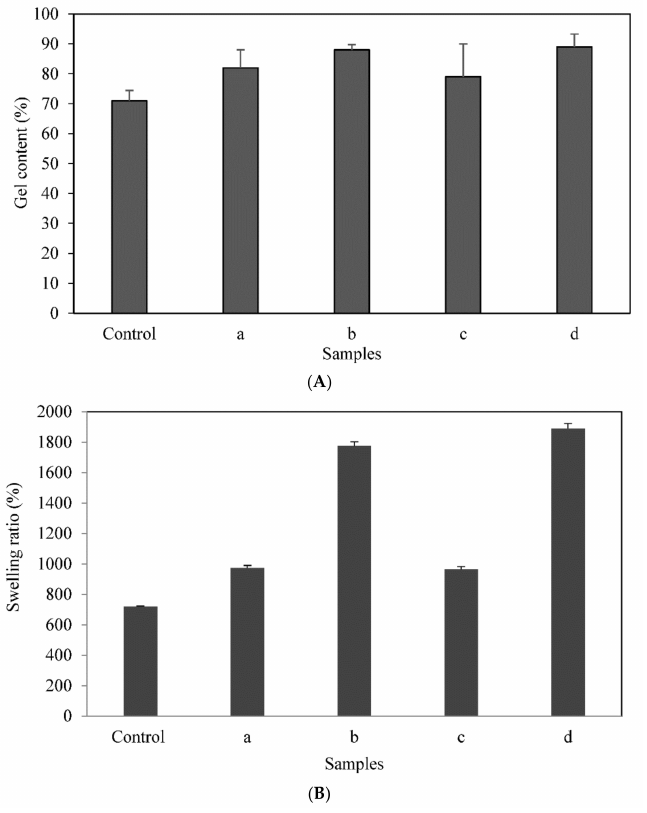
Figure 7. Effect of gel content ( A ) and swelling ratio ( B ); control sponge, ( a ) Alg-CMC ratio (5:5); ( b ) Alg-CMC ratio (5:5) with dextran; ( c ) Alg-CMC ratio (7:3); ( d ) Alg-CMC ratio (7:3) with dextran ( n = 3, mean ±